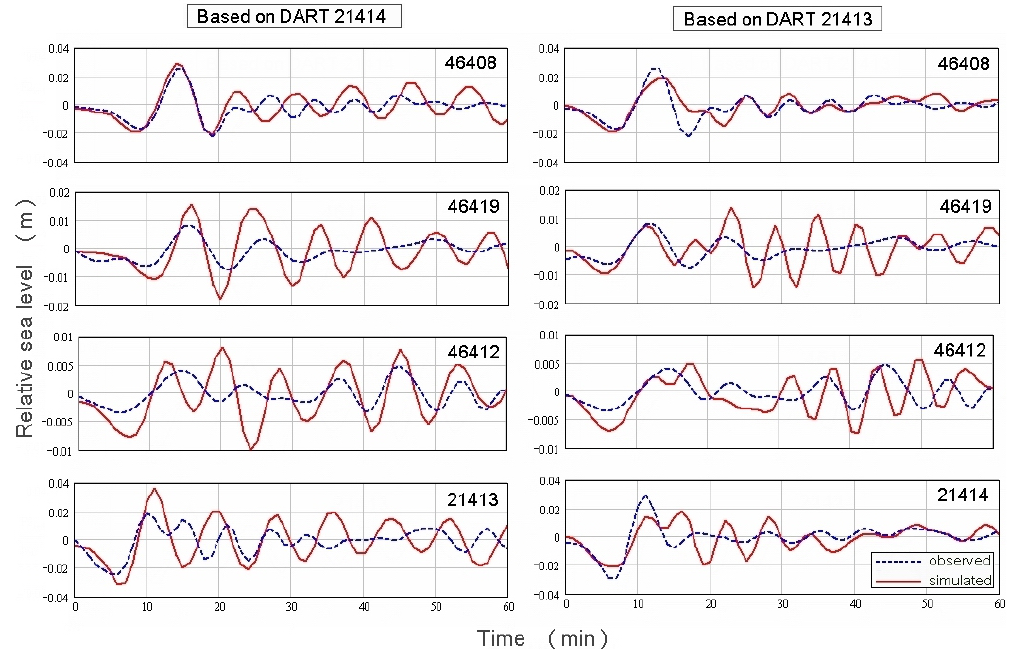
Fig. 6. The same as in Fig. 5 but for the 2007 Simushir tsunami. Left column is for DART 21414 as the reference station; right column is for DART 21413 as the reference station.